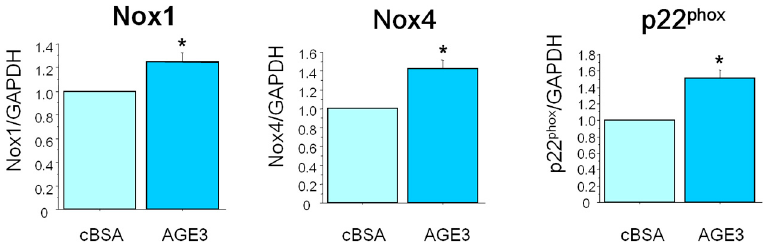
Figure 4. AGE3-BSA increased the mRNA expression of the components of NAD(P)H oxidase. A7r5 cells were treated with cBSA or AGE3-BSA (100 µg/mL) for three days. Total mRNA was isolated, and Nox1, Nox4 and p22 phox mRNA levels were evaluated by real-time PCR, as described in the Method section. GAPDH mRNA was used as a loading control. The data presented here as averages ± SE of at least three experiments. The statistical significance of the results was analyzed by unpaired t -test. The statistical significance was denoted as follows, * p < 0.05 vs. cBSA.